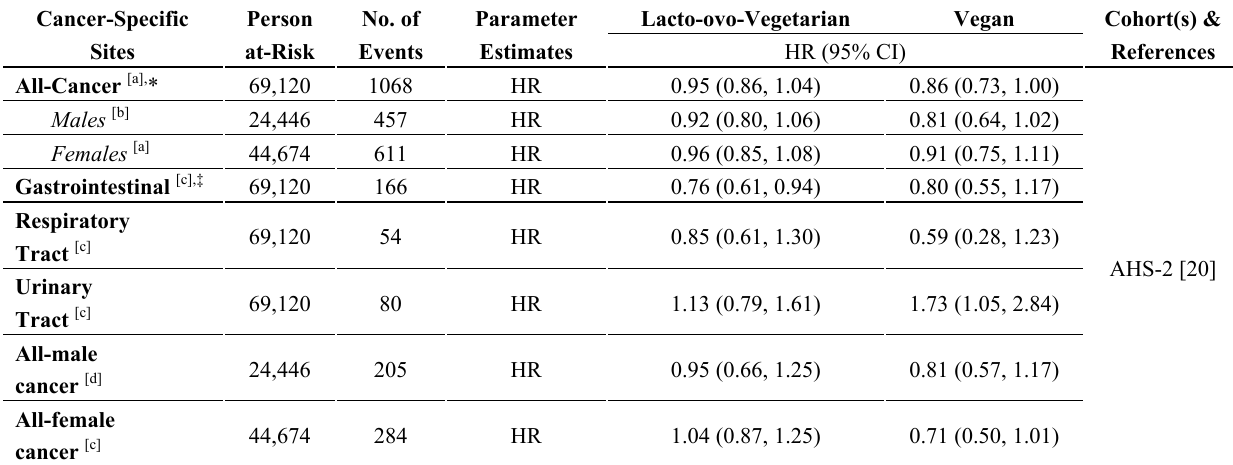
Table 7. All-cancer and site-specific cancers among vegan and lacto-ovo-vegetarian Adventists.